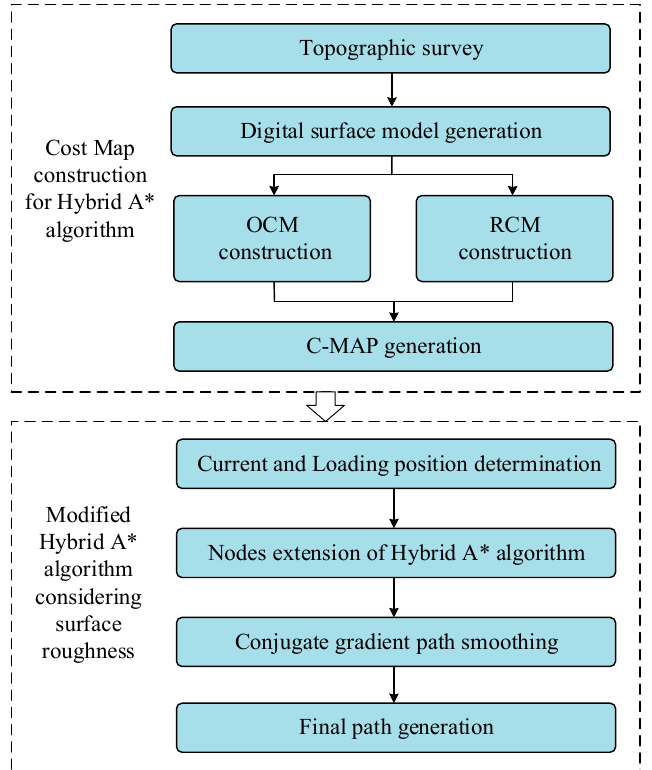
Figure 1. The primary process of map construction and Hybrid A* algorithm planning.